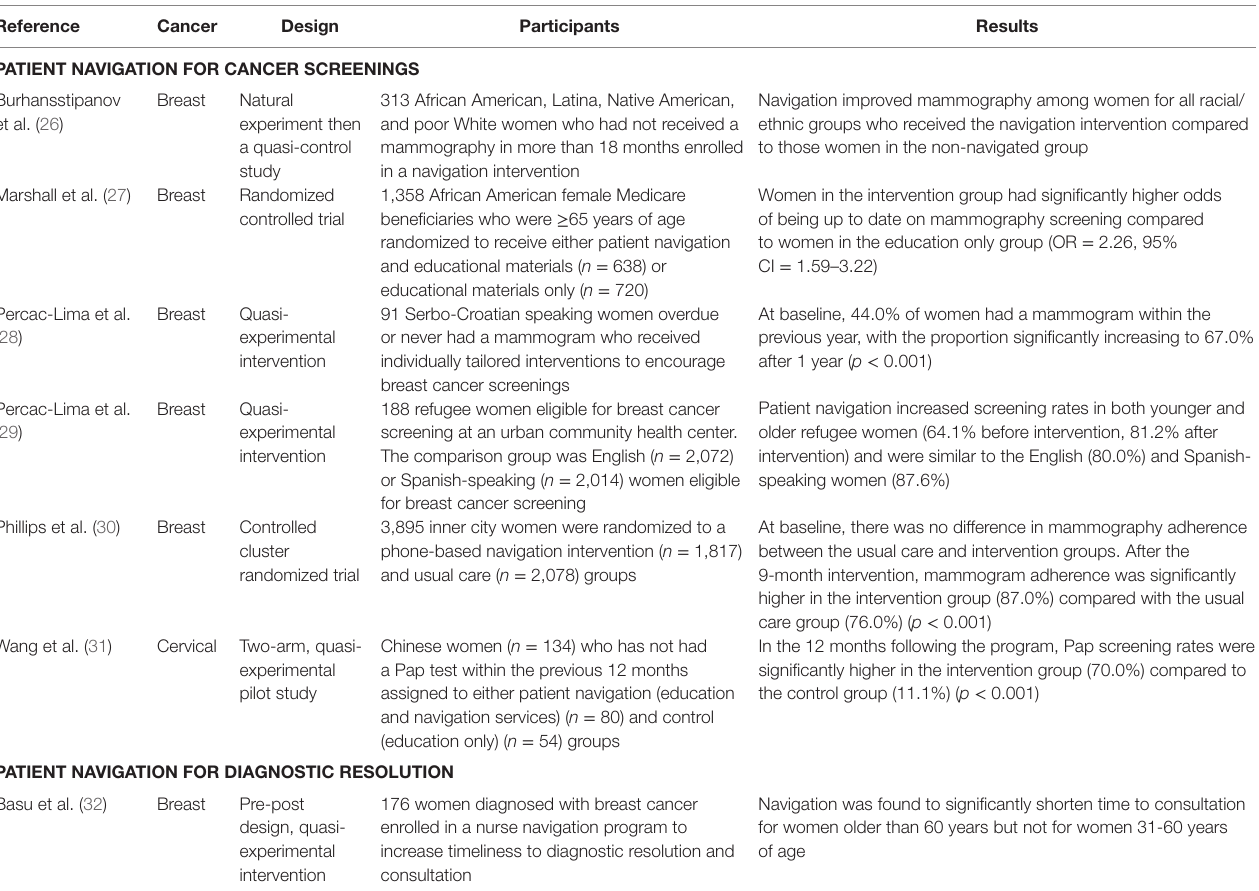
TABLe 1 | Summary of published cancer patient navigation studies: 2010–2015.